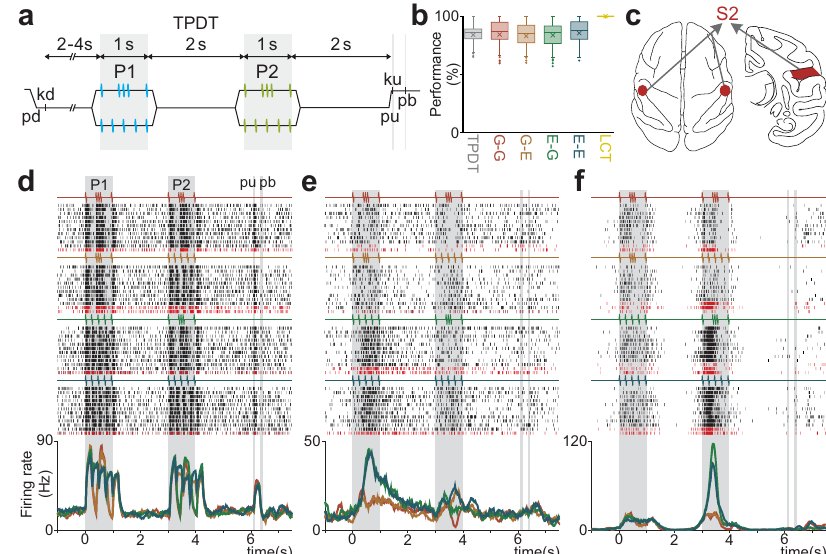
Fig. 1 Temporal pattern discrimination task (TPDT) and activity of single neurons in S2. a Trials ’ sequence of events. The mechanical probe is lowered (pd), indenting the glabrous skin of one fi ngertip of the right, restrained hand (500 µ m); in response, the monkey places its free hand on an immovable key (kd). After a variable prestimulus period (from 2 to 4 s), the probe vibrates for 1s, generating one of two possible stimulus patterns [P1, either grouped (G) or extended (E); mean frequency of 5Hz]. Note that in extended pattern (E), pulses are delivered periodically. After a fi rst delay (2s length, from 1 to 3 s) between P1 and P2, the second stimulus (P2) is delivered, again either of the two possible patterns [P2, either G or E; 1 s duration]; this is also called the comparison period. After a second 2 s delay (from 4 to 6 s) between the end of P2 and the probe up (pu), the monkey releases the key (ku) and presses, with its free hand, either the lateral or the medial push button (pb) to indicate whether P1 and P2 were the same (P1 = P2) or different (P1 ≠ P2). b Performance for the whole TPDT (gray, n = 423 sessions), for each class [G-G (red), G-E (orange), E-G (green), E-E (blue)] and for the whole LCT (yellow, n = 76 sessions). See legend of Supplementary Fig. 5 for box-plot statistics and Supplementary Fig. 5a, b for box-plots and statistics for the individual monkeys. c Top of the brain (left fi gurine) for approaching the secondary somatosensory cortex (S2) and coronal section of the brain (right) for locations of recordings in S2 (red spots). Recordings were made contralateral and ipsilateral to the stimulated fi ngertip. d – f Raster plots of three S2 neurons sorted according to the four possible classes (stimulus pairs). Each row is a single trial, and each tick is an action potential. Trials were interleaved randomly, although the rows were sorted by class afterward (only 10 out of 20 trials per class are shown). Correct and incorrect trials are indicated by black and dark red ticks, respectively. Average fi ring rates (PSTHs), per class, demonstrated in traces below each raster. Color traces indicate the four possible classes: G-G (red); G-E (orange); E-G (green); and E-E (blue). One neuron exhibits a sensory response ( d ) while the other two exhibit categorical activity ( e – f